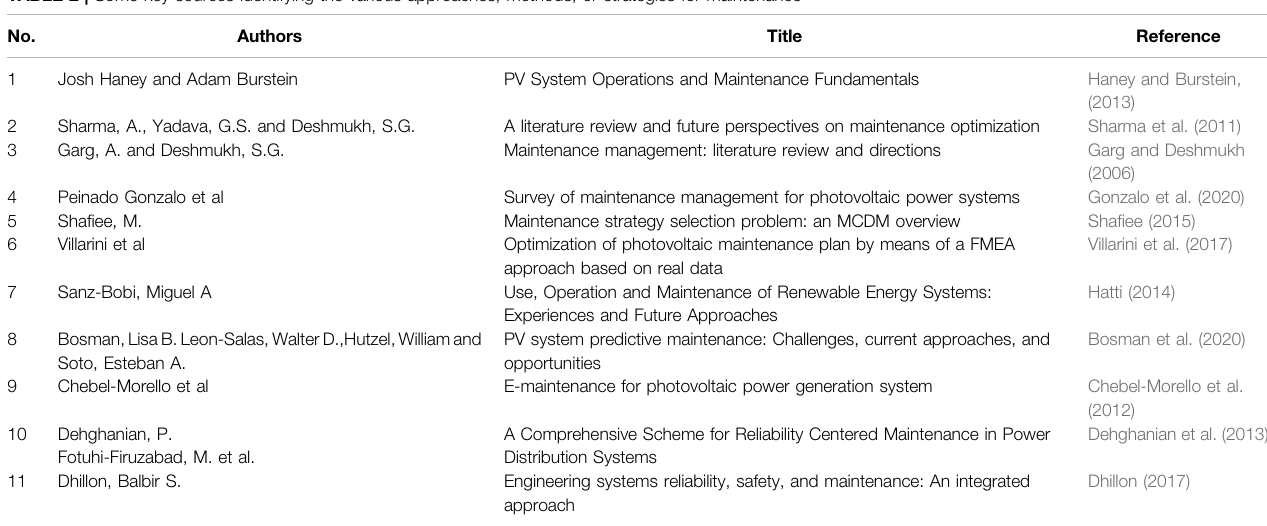
TABLE 2 | Some key sources identifying the various approaches, methods, or strategies for maintenance